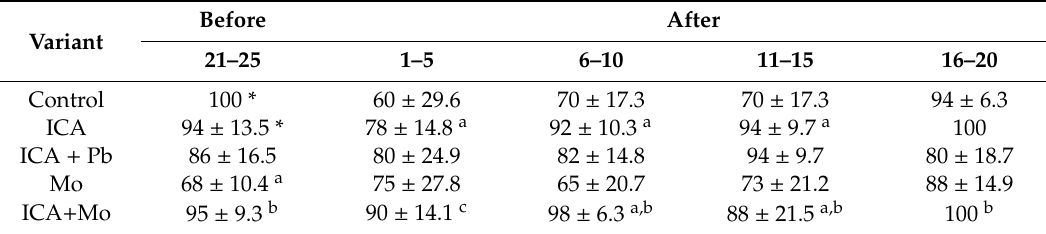
Table 8. E ff ect of ICA and heavy metal salts on the conditioned active avoidance response (CAAR) (% of the number of trials) before and after its spatial